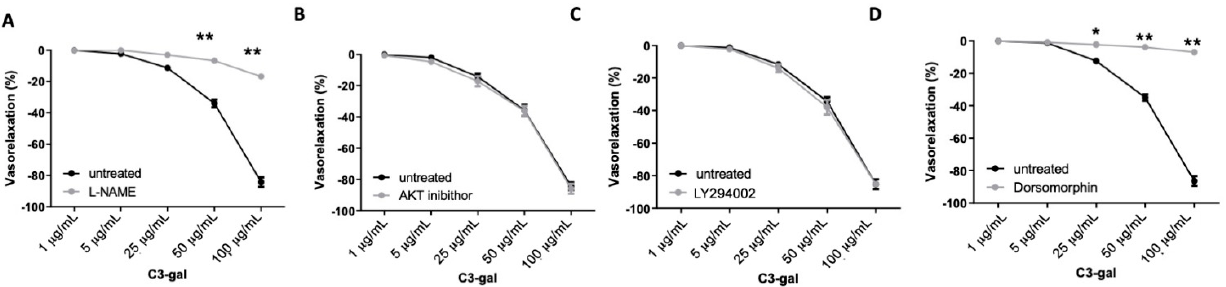
Figure 4. Representative high-power micrographs of 10 µm sections of mice mesenteric arteries loaded for 2 h with 4,5-diaminoflfluorescein (DAF-FM) reveal nitric oxide production after treatment with acetylcholine (Ach 10 − 6 M) or single anthocyanins (50 µg/mL). Scale bar: 100 µm. Bar graph shows the mean fluorescence intensity of N = 4 section for each anthocyanin. * p < 0.05 versus all.